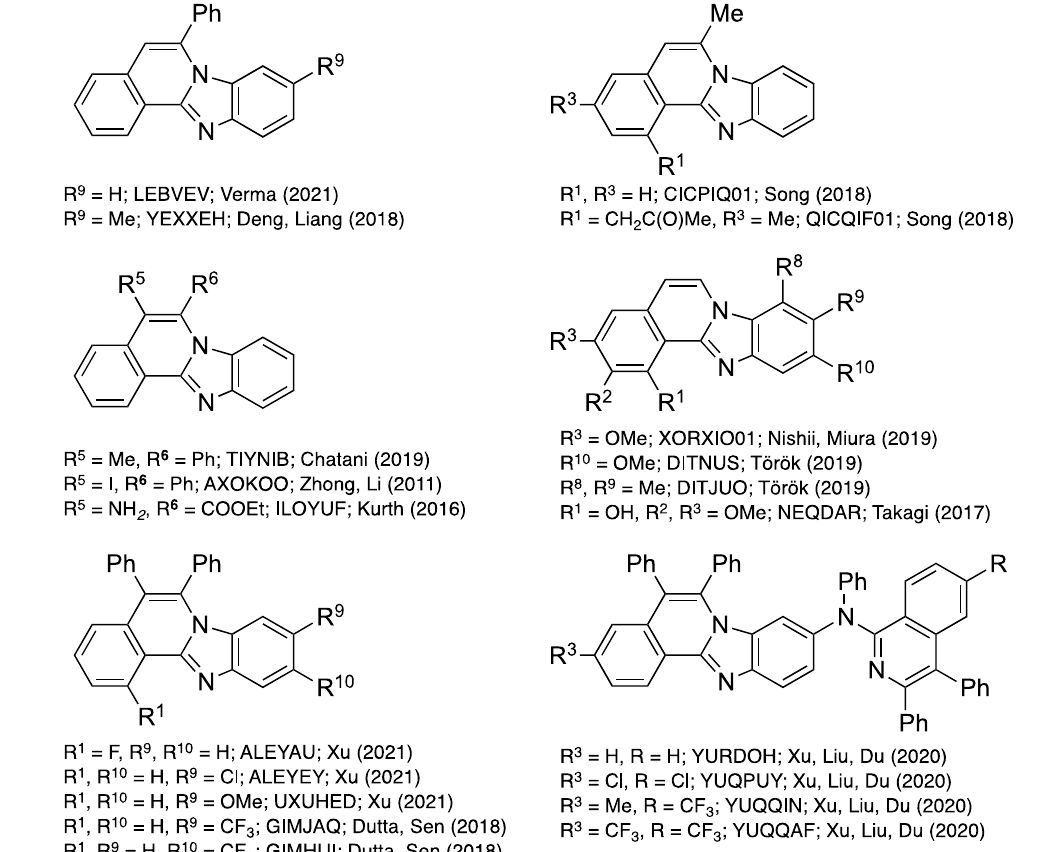
Figure 22. Structures and CSD reference codes of crystallographically characterized derivatives of benzimidazo[2,1- a ]isoquinolines 1